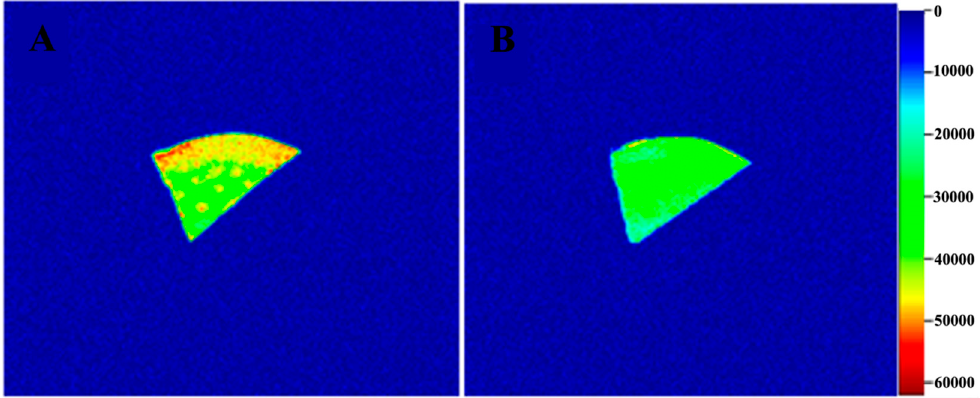
Figure 2. Cross-sectional MRI images of G. elata ( A ) before steaming and ( B ) after steaming.